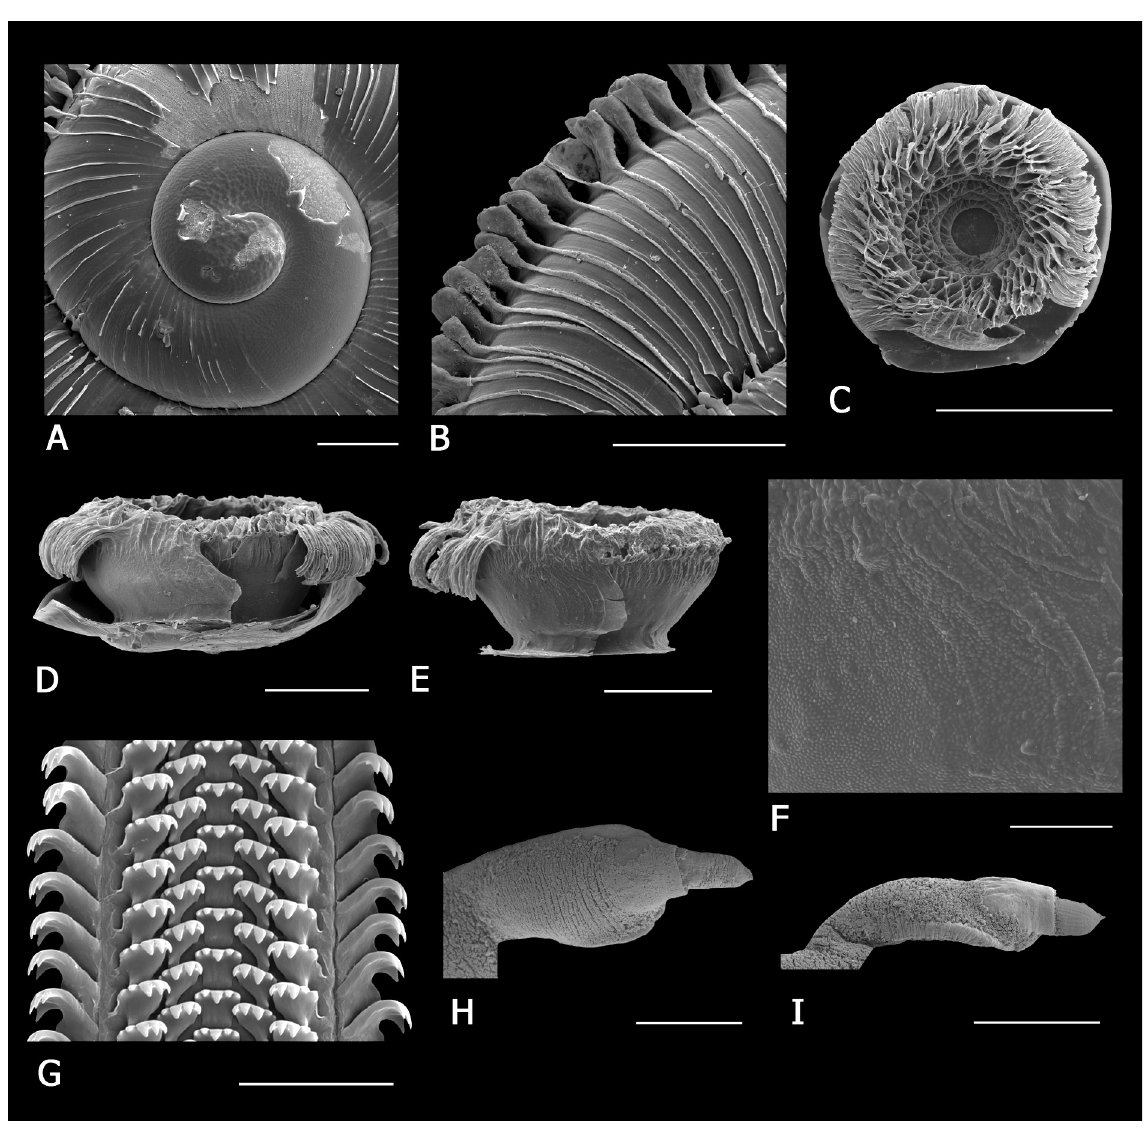
Fig. 23. Chondrocyclus putealis Connolly, 1939. A . Protoconch (ELM W3656). B . Detail of axial lamellae of periostracum (ELM W3656). C . Operculum (ELM W3656). D . Operculum, with disc trimmed (ELM W3656). E . Operculum with some fringe missing (NMSA V9390). F . Detail of sculpture of operculum wall (NMSA V9390). G . Portion of radula (ELM W3656). H . Penis, dorsal view (ELM W3657). I . Penis, lateral view (ELMW3657). Scale bars: A–B = 200 µm; C = 1 mm; D–E, H–I = 500 µm; F = 100 µm; G = 50